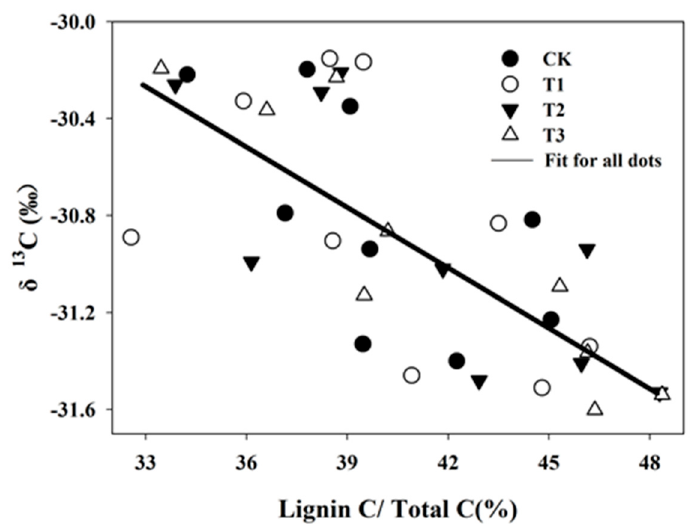
Figure 2. Relationship between δ 13 C values (‰) and proportion of lignin fraction C to the total C (Lignin C/Total C) (%) in litter residues of different decomposition layers under the SAR treatment (CK = control treatment; T1 = pH 4.0 treatment; T2 = pH 3.5 treatment; and T3 = pH 3.0 treatment). A linear regression model was fitted for all data points ( y = − 27.49 − 0.08 x , R 2 = 0.53, P < 0.0001) as there were no significant differences in mode parameters among treatments.